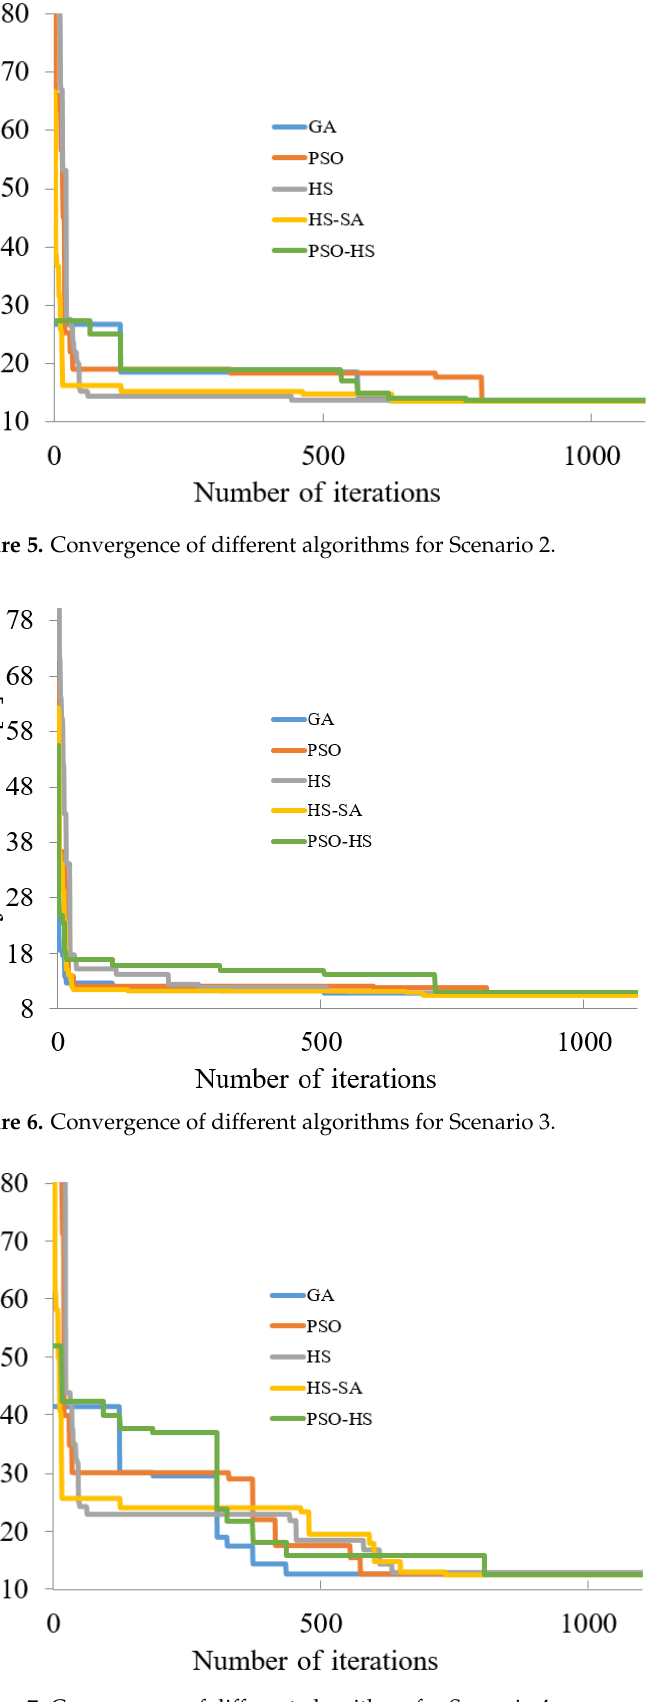
Figure 7. Convergence of different algorithms for Scenario